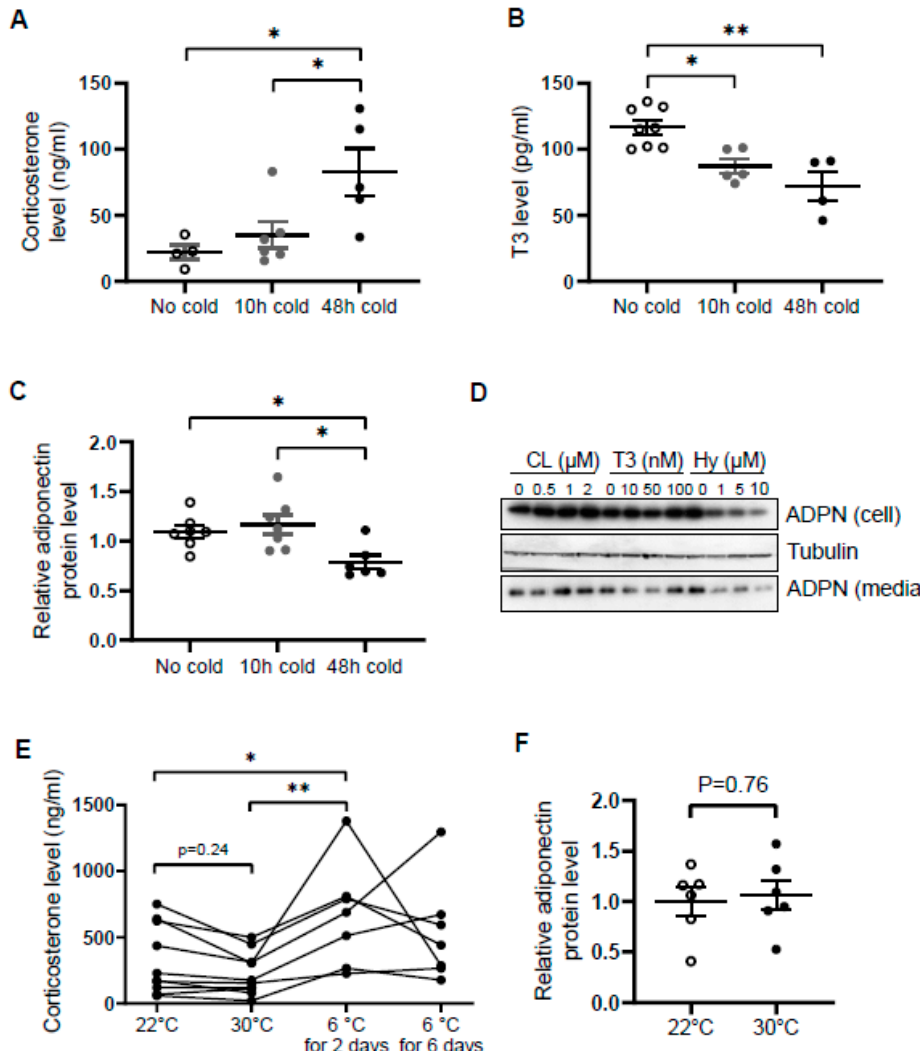
Figure 1. Circulating levels of corticosterone are elevated while adiponectin levels are suppressed by acute cold stress. Acute cold stress increased the circulating levels of corticosterone ( A ), while suppressed the levels of T3 ( B ) and adiponectin ( C ) in serum. White dots, No cold group (mice housed at 22 °C, n = 4–8); gray dots, 10 h cold group (mice housed at 6 °C for 10 h, n = 5–7); black dots, 48 h cold group (mice housed at 6 °C for 48 h, n = 4–6). ( D ). Treatment of hydrocortisone suppressed expression and release of adiponectin in differentiated 3T3-L1 adipocytes in a dose-dependent manner despite no significant effect when treated with CL or T3 for 24 h. ( E ) Circulating levels of corticosterone did not significantly alter at 30 °C or after 6 days of cold exposure. Each black dot indicates the individual mouse. ( F ) Adiponectin expression showed little change between mice housed at 22 °C and 30 °C. White dots, mice housed at 22 °C, n = 6; gray dots, mice housed at 30 °C, n = 6. ADPN, adiponectin. The data in Figure 1A–C are presented as mean ± S.E.M. * p < 0.05, ** p < 0.01.